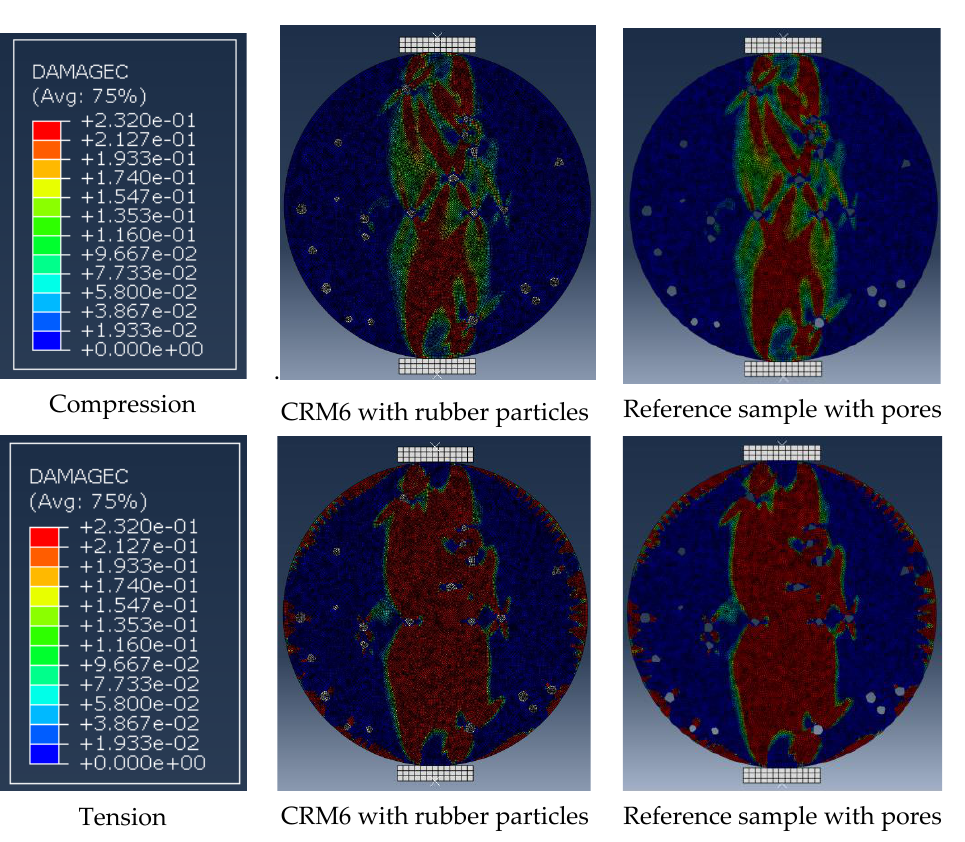
Figure 17. Comparison of damage modes between CRM specimens and reference specimens with pores. Table 7. The tensile strength of CRM obtained by numerical